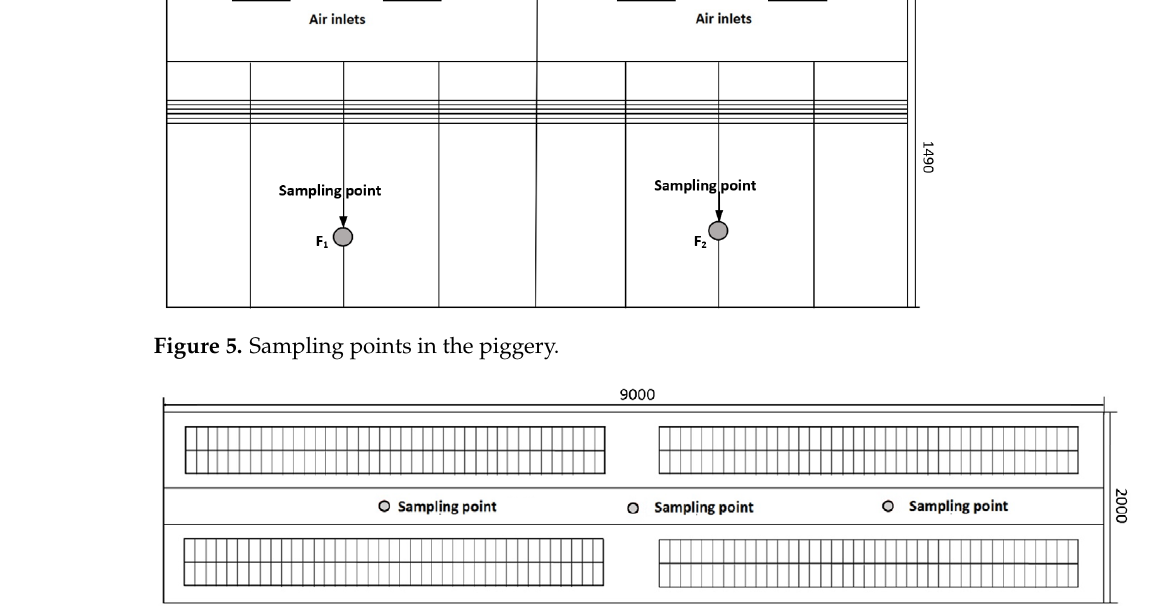
Figure 6. Sampling points in dairy cow barn.